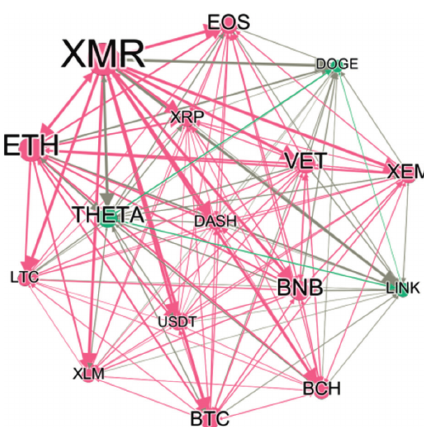
Figure 41: Risk spillover under R4.